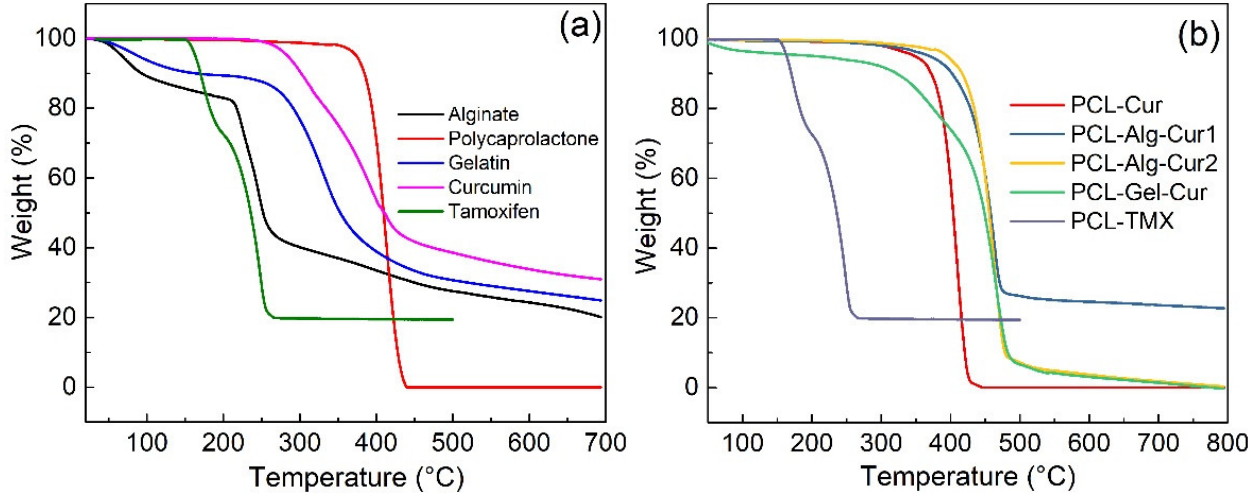
Figure 5. Thermogravimetric curves of ( a ) the materials used in the manufacture of the nanofibers, and ( b ) the uniaxial and coaxial nanofibers.